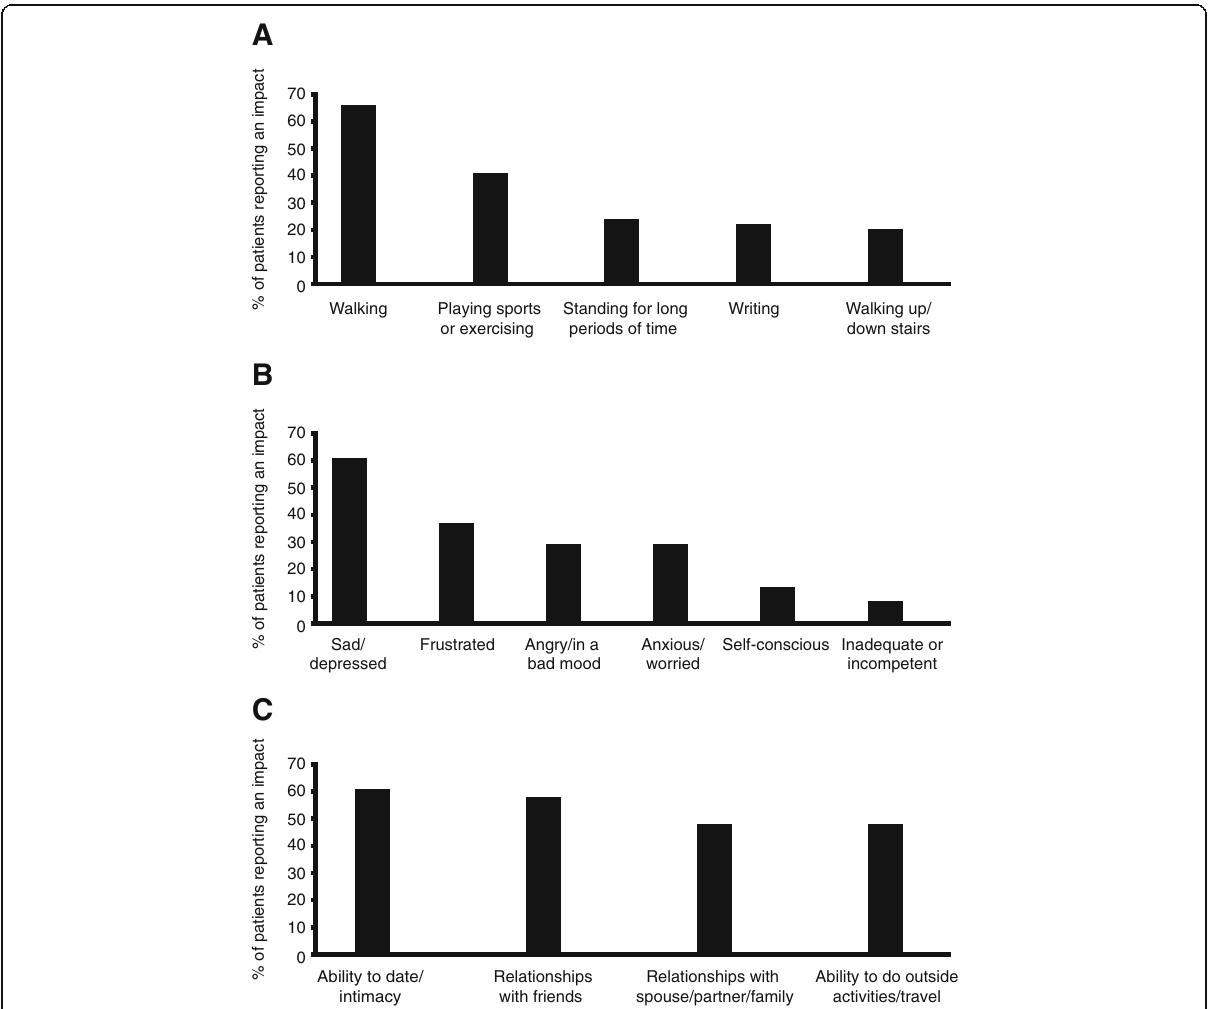
Fig. 2 Patient-reported impact of SLE on functioning according to the CE interviews. A. Physical functioning ( n =41); B. Emotional functioning ( n =38); C. Social functioning ( n